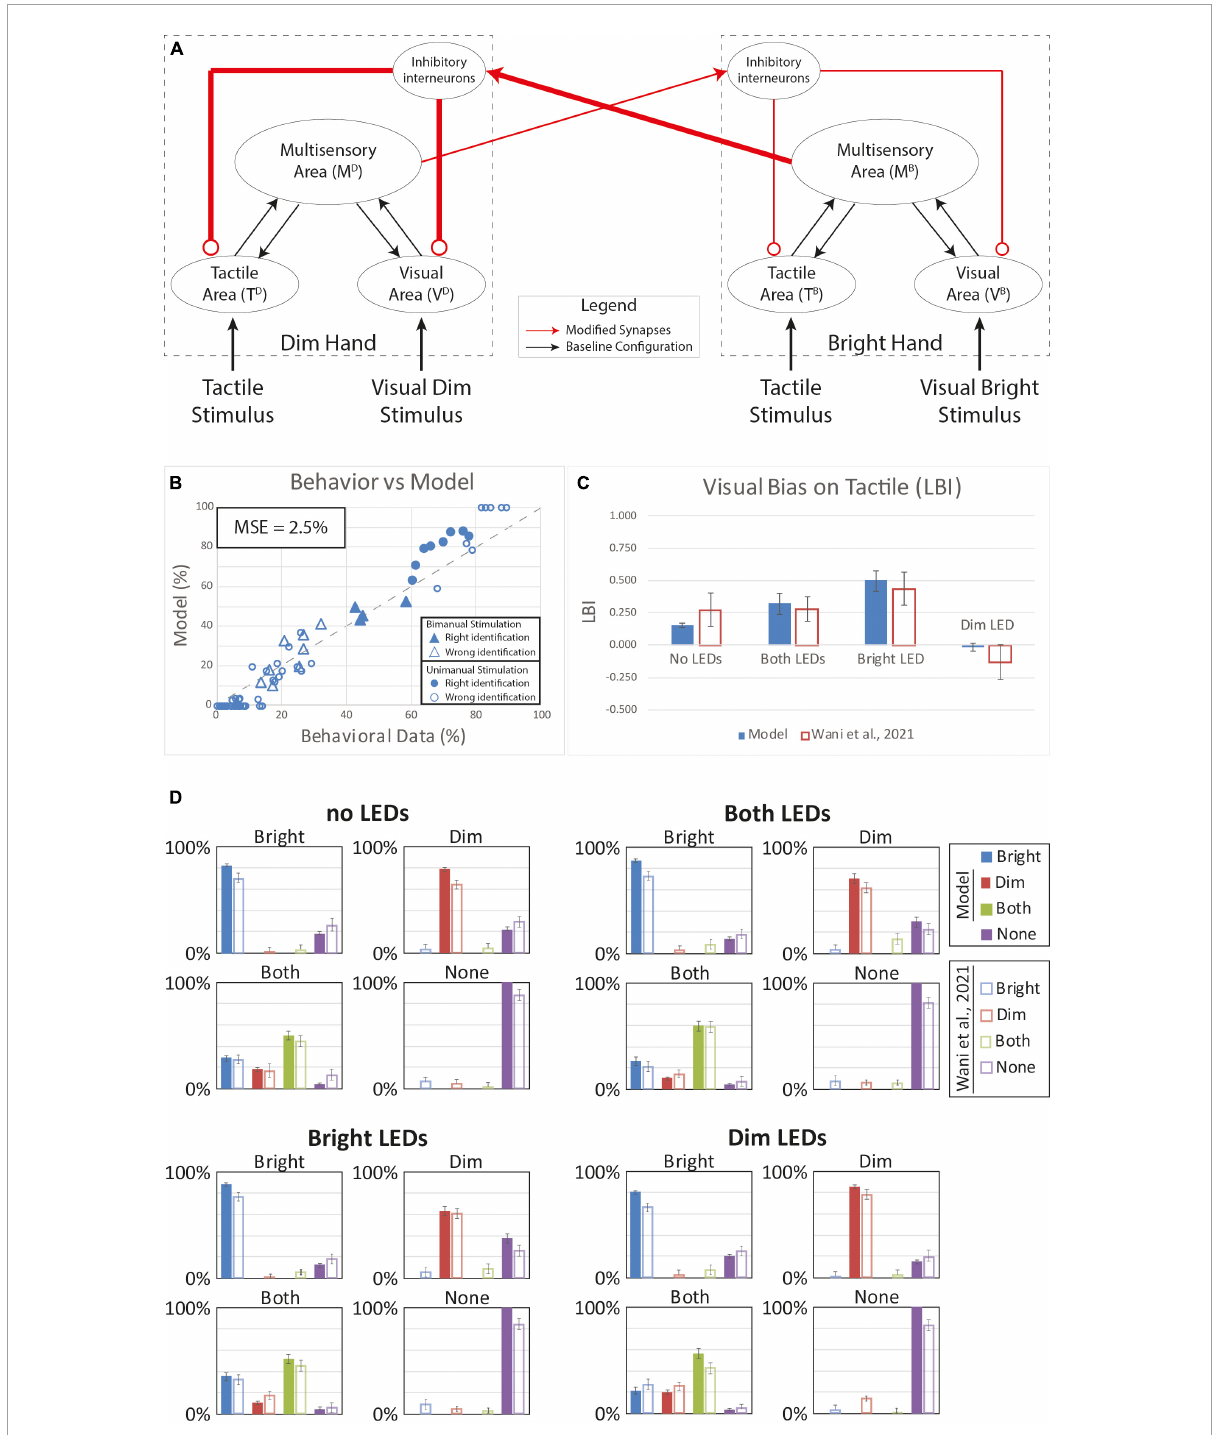
FIGURE6 Simulated tactile perception with stronger competition between the two hands’ neural representations. (A) Model’s structure with the altered pattern of connectivity. Red lines highlighted the modified synapses. Thick synapses represent stronger reinforcement; thin lines correspond to a weaker reinforcement. (B) Behavioral data from Wani et al. (2021) are compared with Model’s results, for the 16 different stimuli configurations. The dashed line represents the “perfect” match between simulations and behavioral results. In the diagram the triangles represent the tactile responses in case of bimanual tactile stimulations, irrespective of the visual stimuli. Full triangles refer to the correct identification of bimanual stimulations; empty triangles report the percentages of different sensory perceptions. Circles report the responses